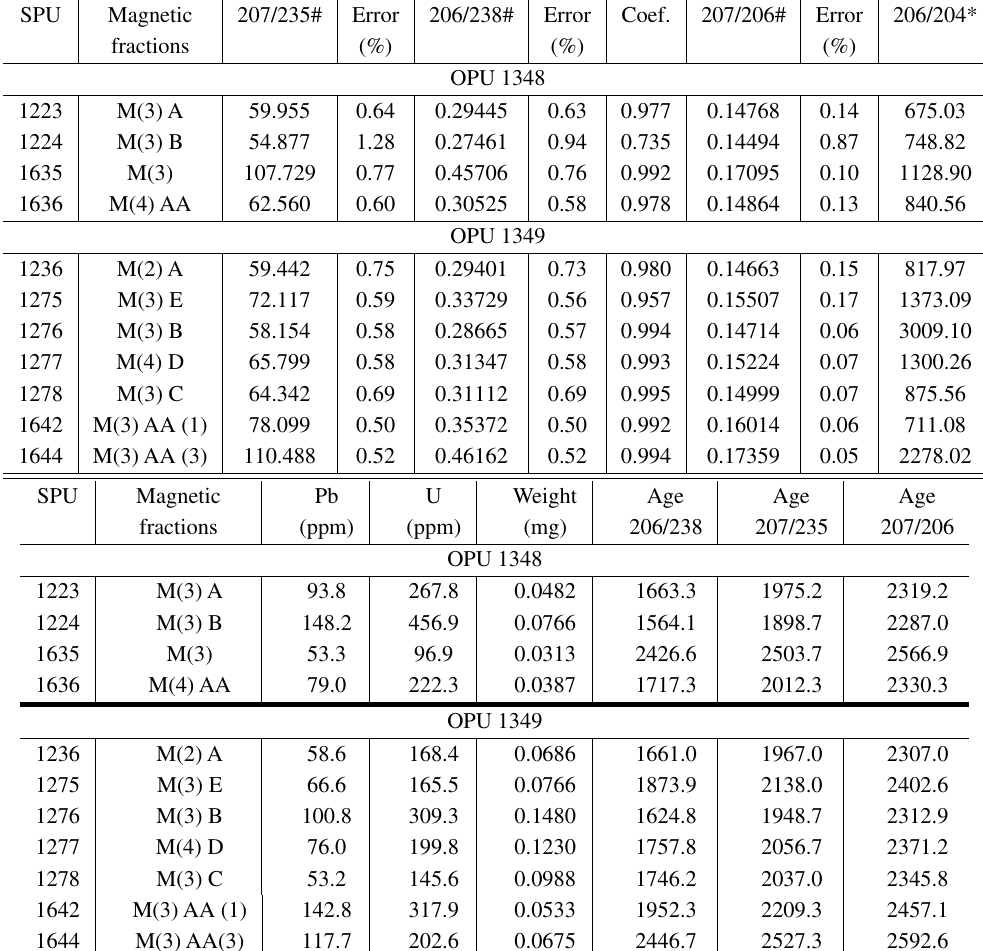
Isotopic data obtained from selected zircon fractions of mesosome (OPU 1349) and leucosome (OPU 1348) samples.